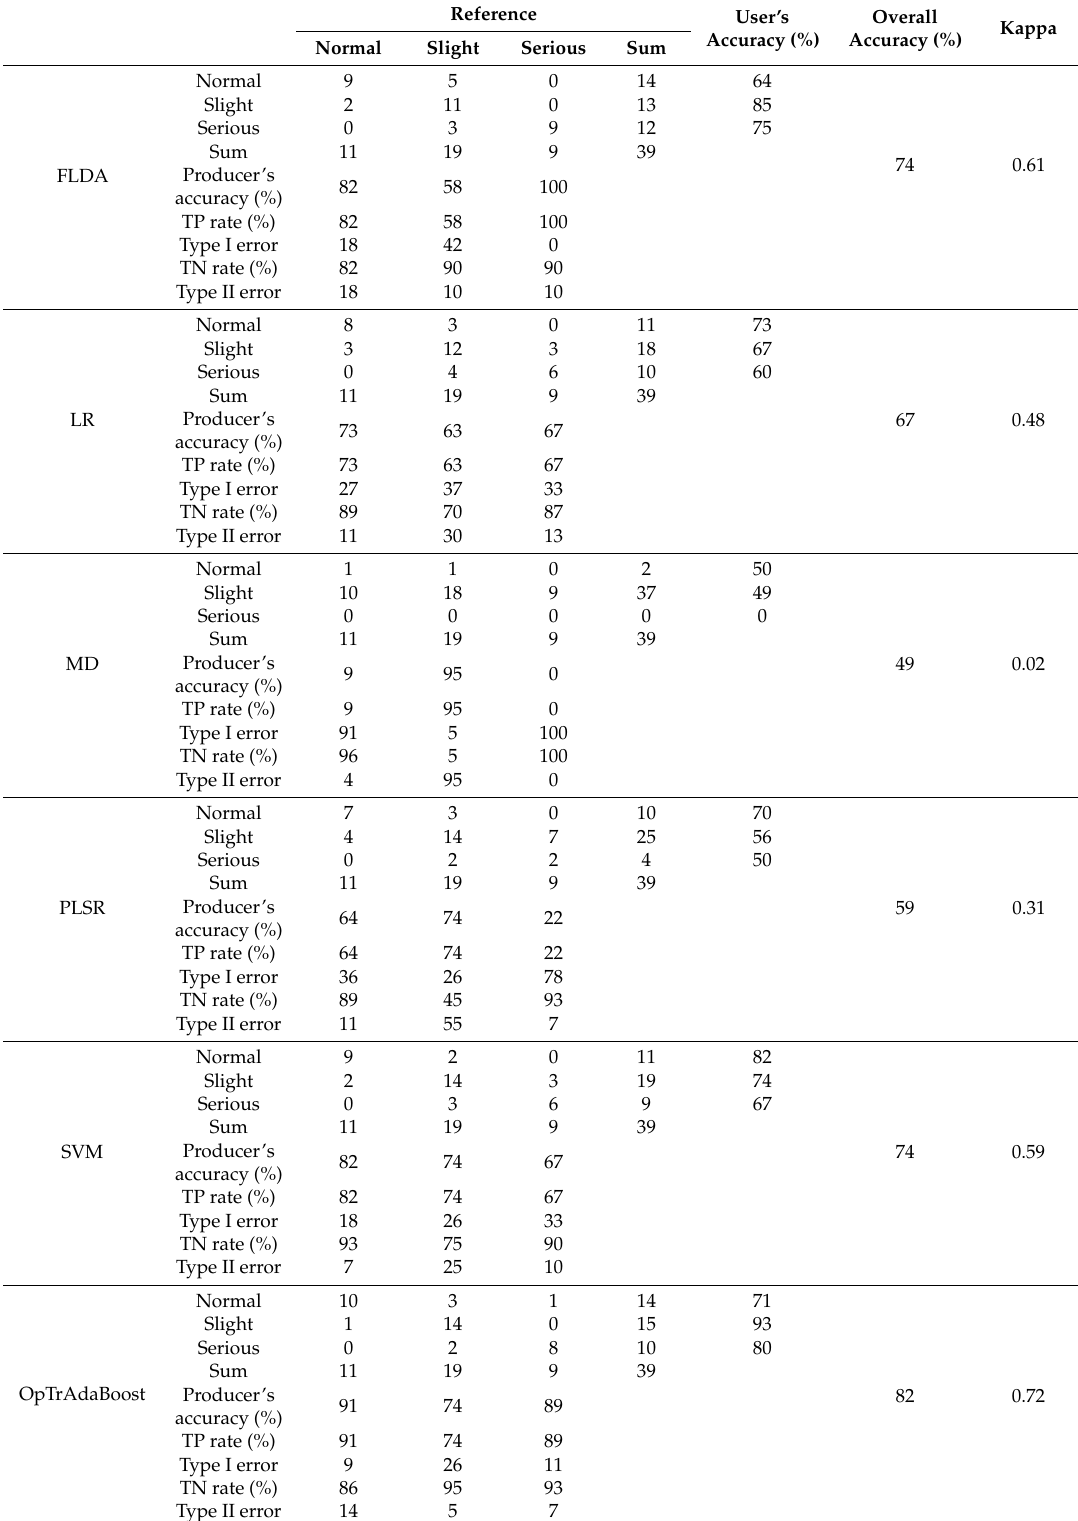
Table 5. Overall verification results of five commonly used algorithms and